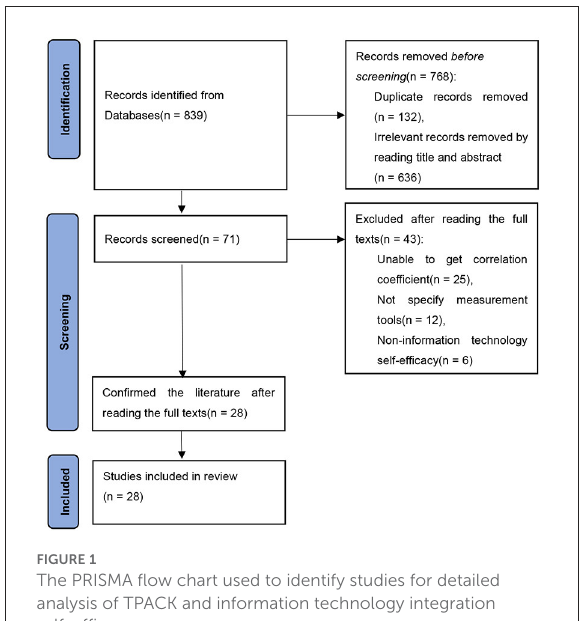
FIGURE1 The PRISMA flow chart used to identify studies for detailed analysis of TPACK and information technology integration